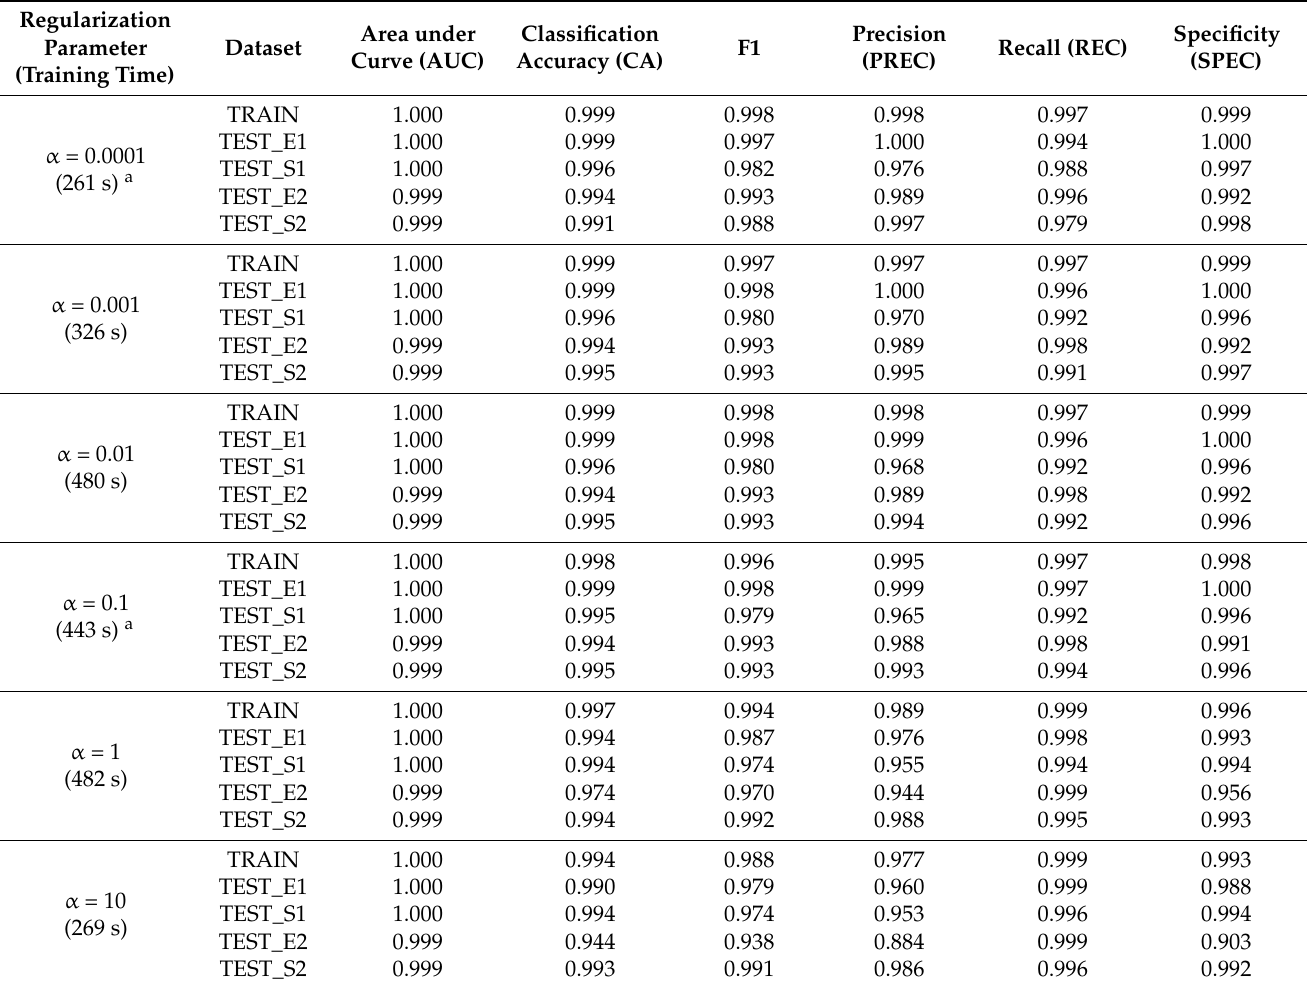
Table A3. Classification performance metrics of the training and testing datasets for OFF events.